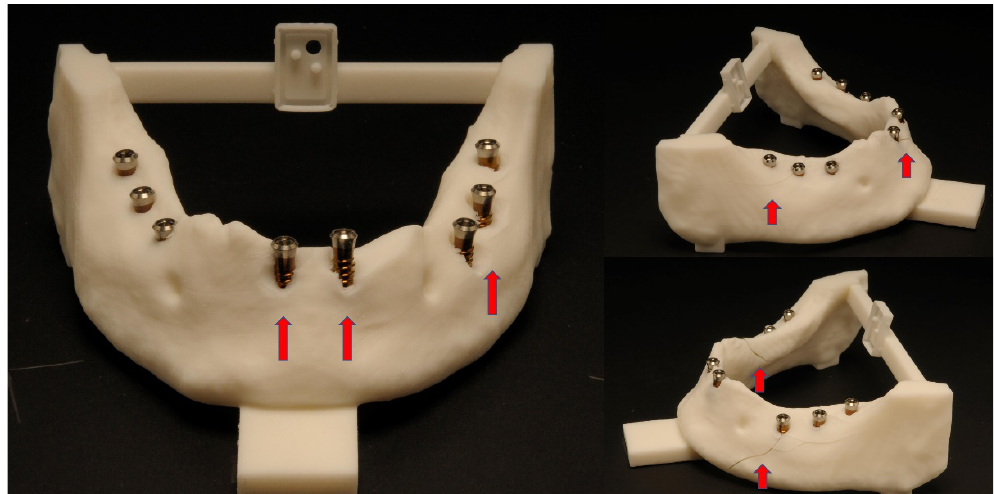
Figure 7. The main problems during the first session were that the acrylic jaw fractured due to excessive pressure or mishandling of the implant placement. Furthermore, the correct depth was not always achieved with the drills. Some of these mistakes were shown with the red arrows.